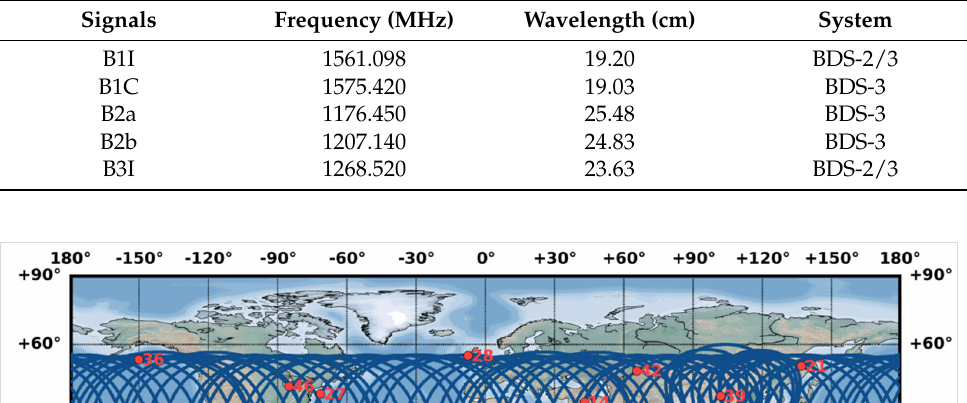
Table 1. Frequency signals of BDS-2 and BDS-3 satellites.